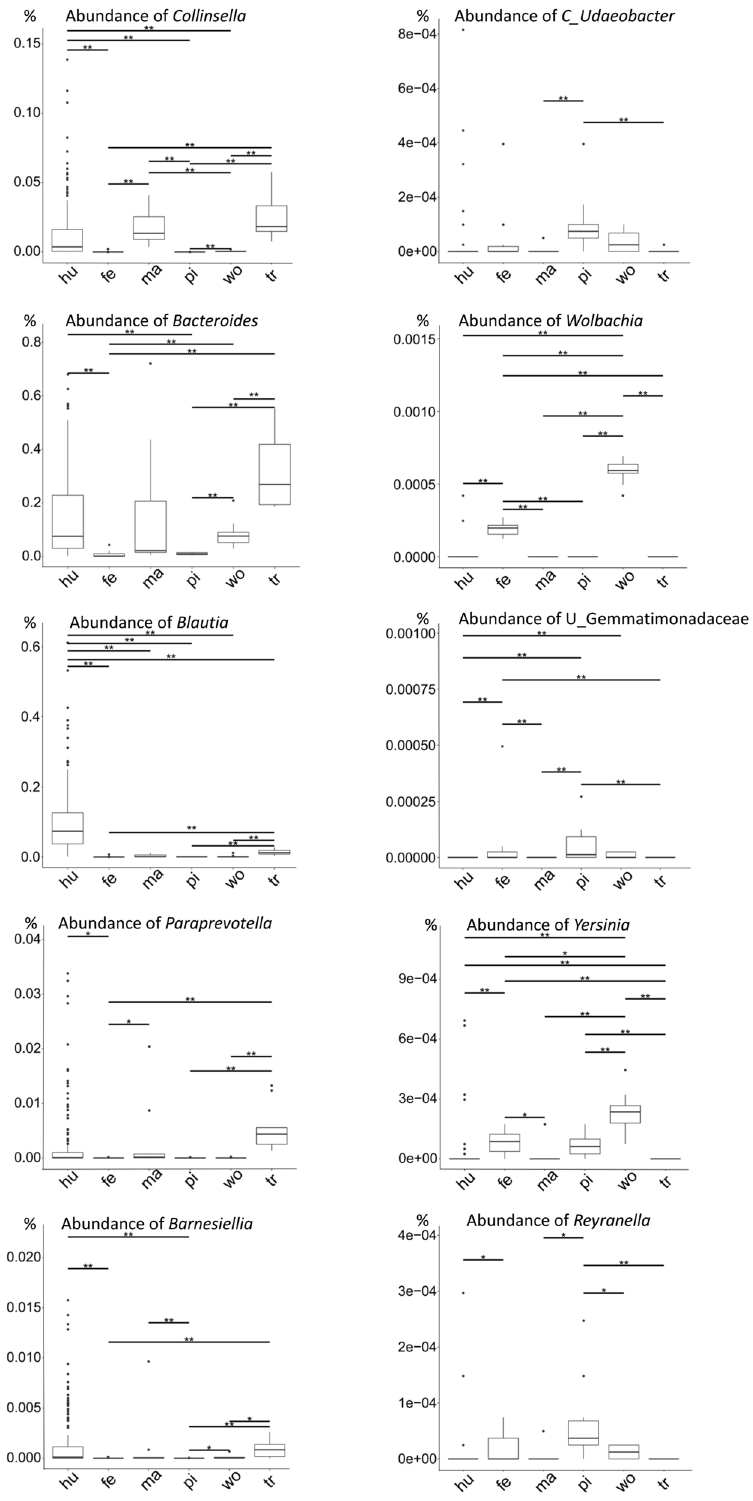
Figure 4. Host phylogenetic related genera detected with Metastat. The host phylogenetic related genera are detected with Metastat. The genera of Collinsella , Bacteroides , Blautia , Paraprevotella , and Barnesiella predominately existed in the microbiota of human (hu), marmoset (ma), and tree shrew (tr). The Candidatus Udaeobacter , Wolbachia , unidentified Gemmatimonadaceae, Yersinia , and Reyranella existed in the microbiota of ferret (fe), mini pig (pi), and woodchuck (wo). The abundance of each genus is shown as value in percent (%). The statistic differences of the genera abundances from different host species are indicated with one asterisk ( *, Wilcox p-value < 0.05) or two asterisks ( **, Wilcox p-value <